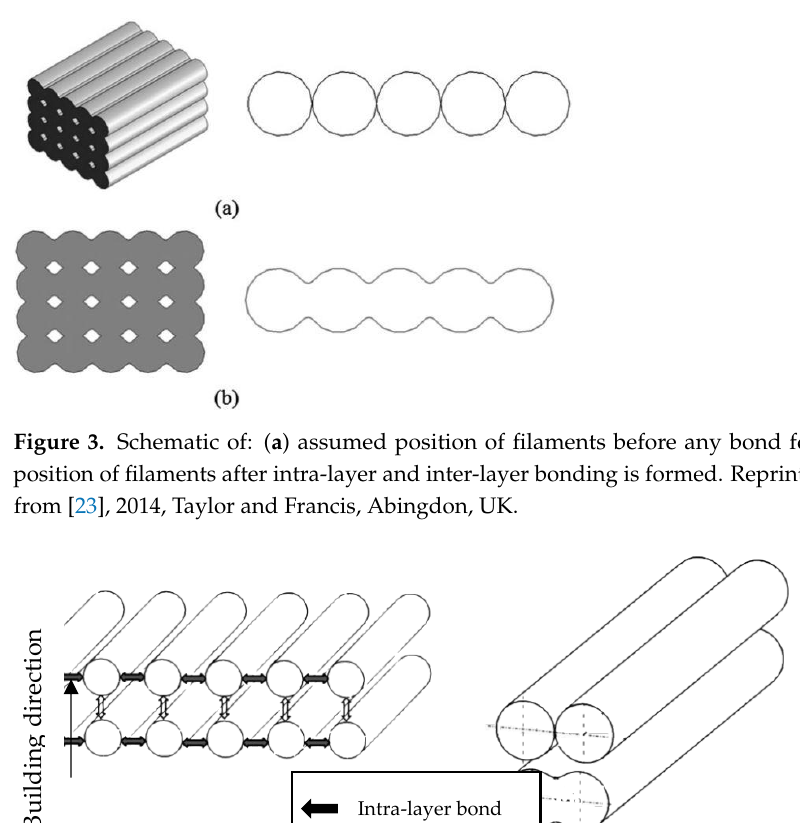
Figure 2. Formation of the neck between filaments: ( 1 ) surface contacting, ( 2 ) neck growth, and ( 3 ) diffusion at interface, Reprinted with permission from [24], 2004, Elsevier, Amsterdam, The Neth- erlands.